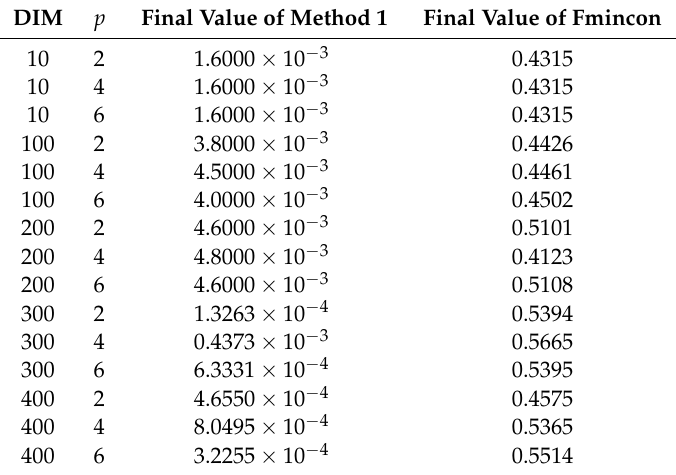
Table 7. Numerical results for Example